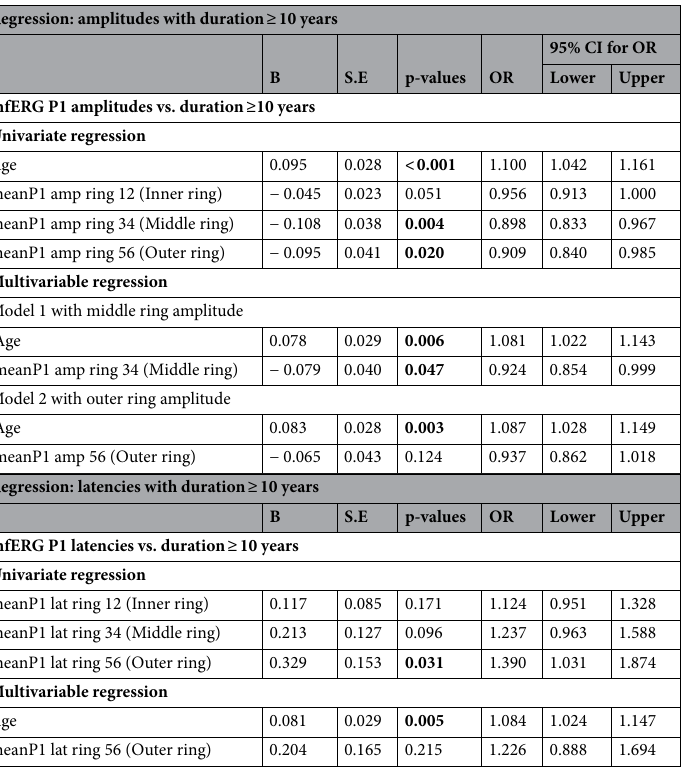
Table 4. Association between duration of diabetes, age and mfERG measures per mfERG rings. Significant values are in bold. Variables entered into equation are chosen whose p-values were < 0.05 on univariate analysis; lat latencies, amp amplitudes (nV/deg 2